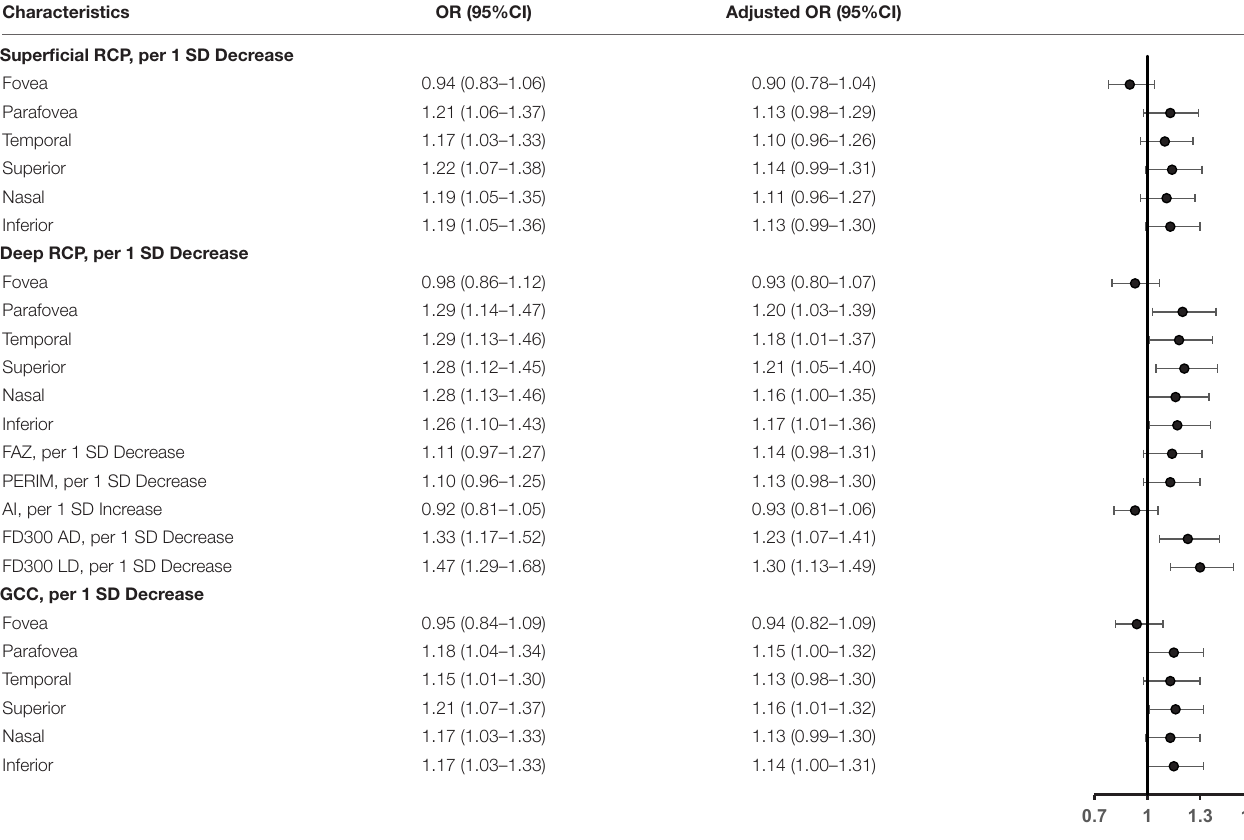
TABLE 3 | Association of retinal capillary plexus and ganglion cell complex with cognitive impairment in the logistic regression model.